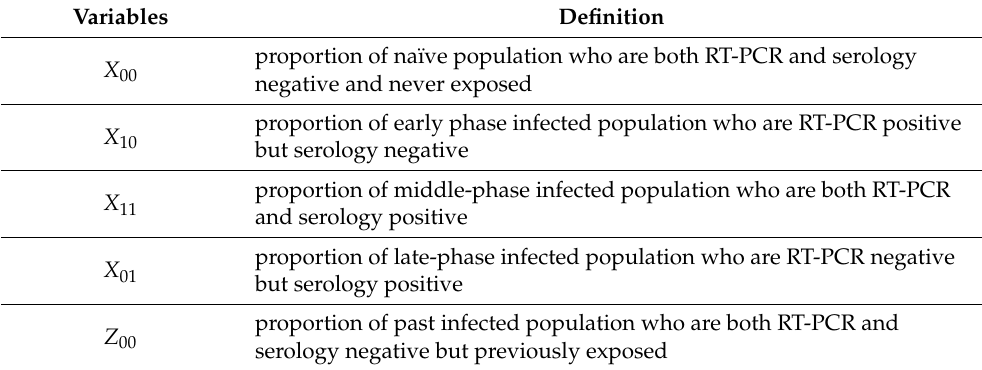
Table 2. A list of patient compartments or model variables and their definitions. Variables Definition proportion of naïve population who are both RT-PCR and serology X 00 negative and never exposed proportion of early phase infected population who are RT-PCR positive X 10 but serology negative proportion of middle-phase infected population who are both RT-PCR X 11 and serology positive proportion of late-phase infected population who are RT-PCR negative X 01 but serology positive proportion of past infected population who are both RT-PCR and Z 00 serology negative but previously